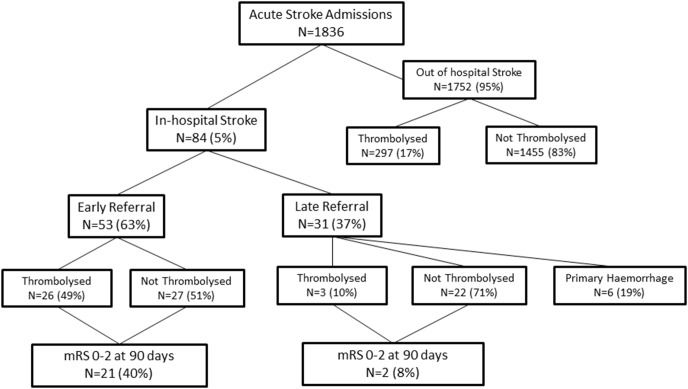
Flow of patients included in the study between Jan 2009 to December 2010.